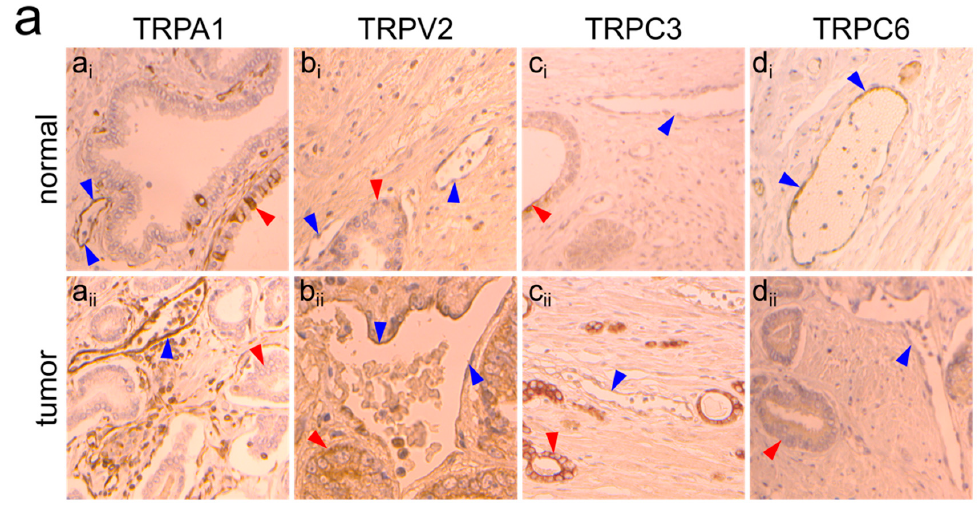
Figure 2. Figure 2. Cont.